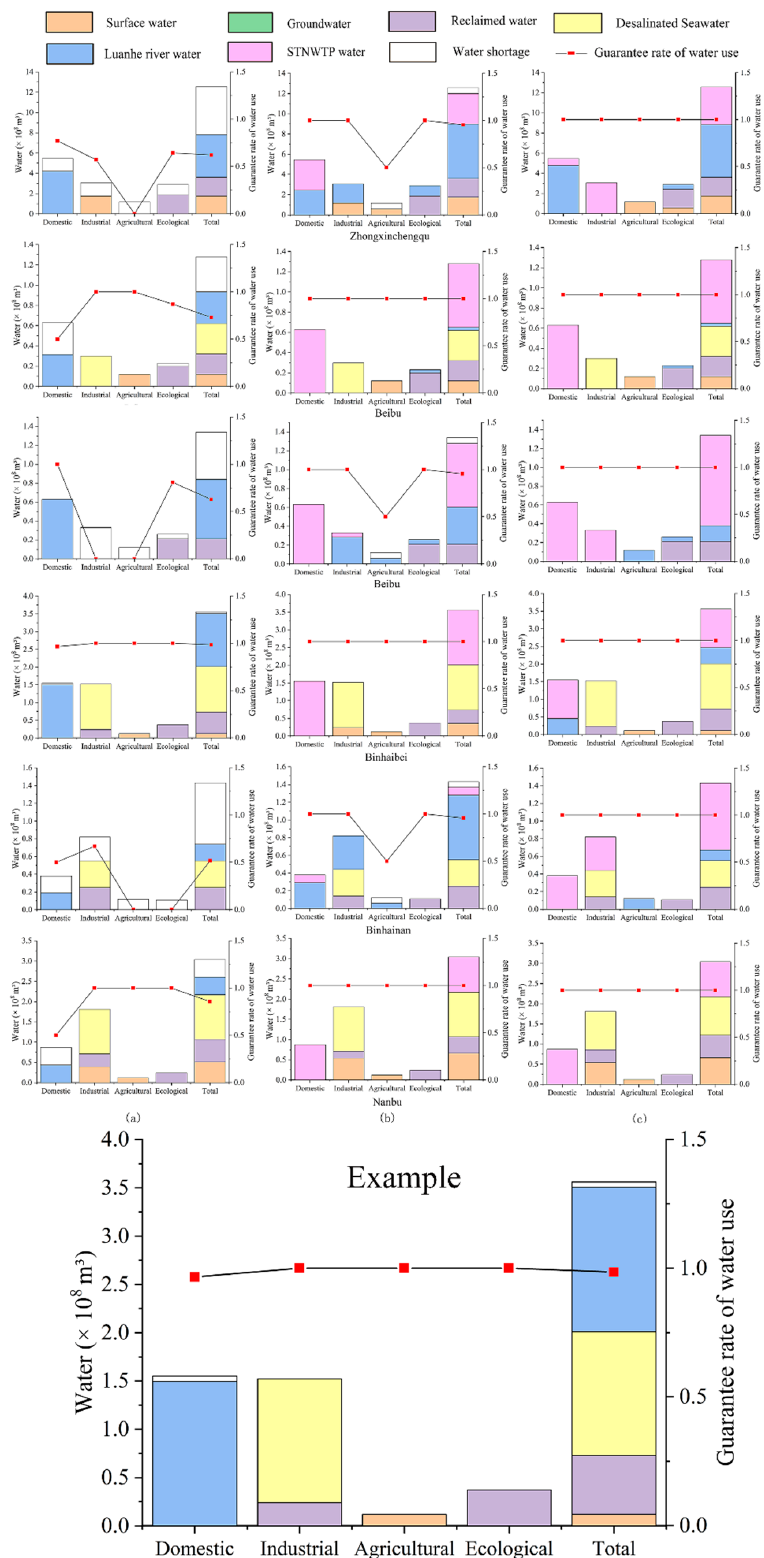
Figure 9. Guarantee rate of water use in the Zhongxinchengqu and Binhaixinqu areas for: ( a ) (surface water 50% + Luanhe river water 75%); ( b ) (surface water 50% + Luanhe river water 75% + STNWTP water 95%); ( c ) (surface water 50% + Luanhe river water 75% + STNWTP water 75%). All coordinates in the figure are the same and shown in Example.